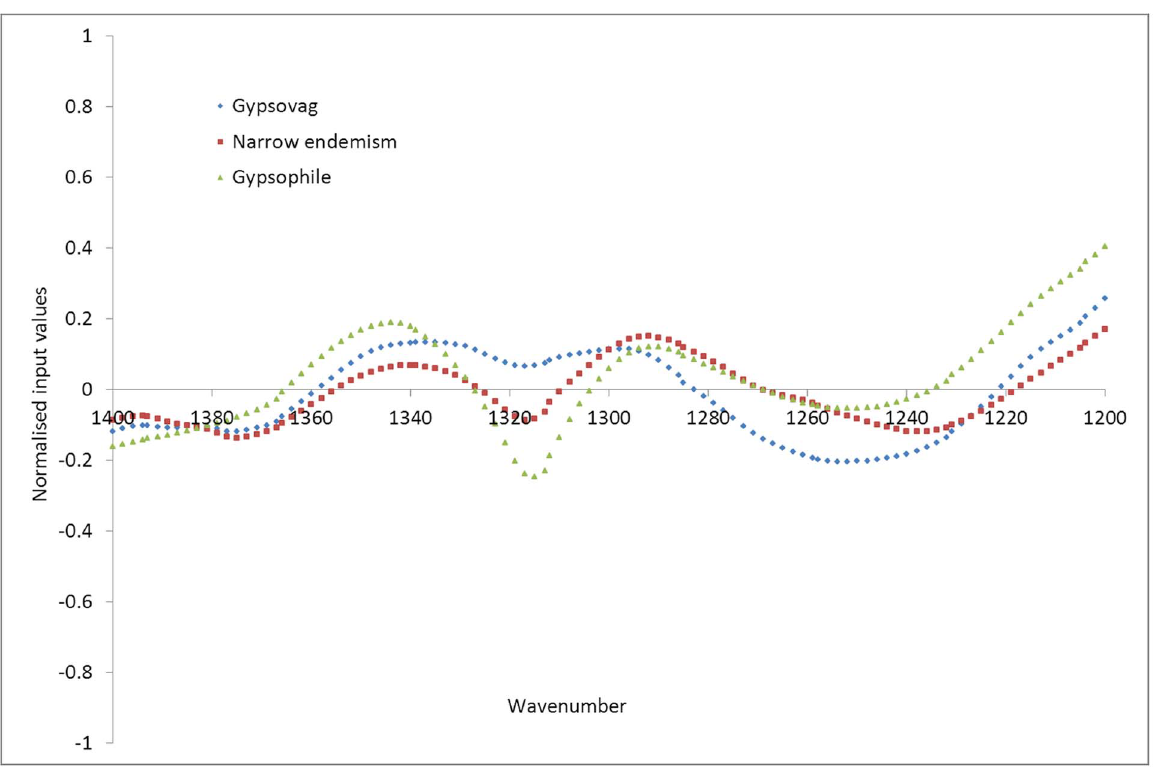
Figure 6. Input datasets averaged over each of the plant types (gypsovags in blue, narrow gypsum endemisms in red, wide gypsophiles in green), for the input wavenumber range 1200 to 1400 cm 2 1 .